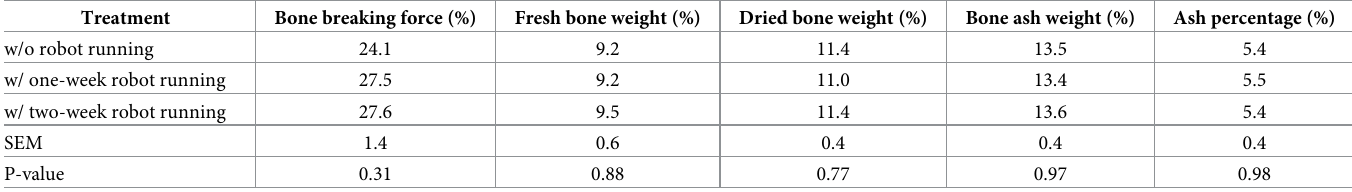
Table 7. Coefficient of variations (CV) of bone breaking force, fresh bone weight, dried bone weight, bone ash weight, and ash percentage under the treatments. Treatment